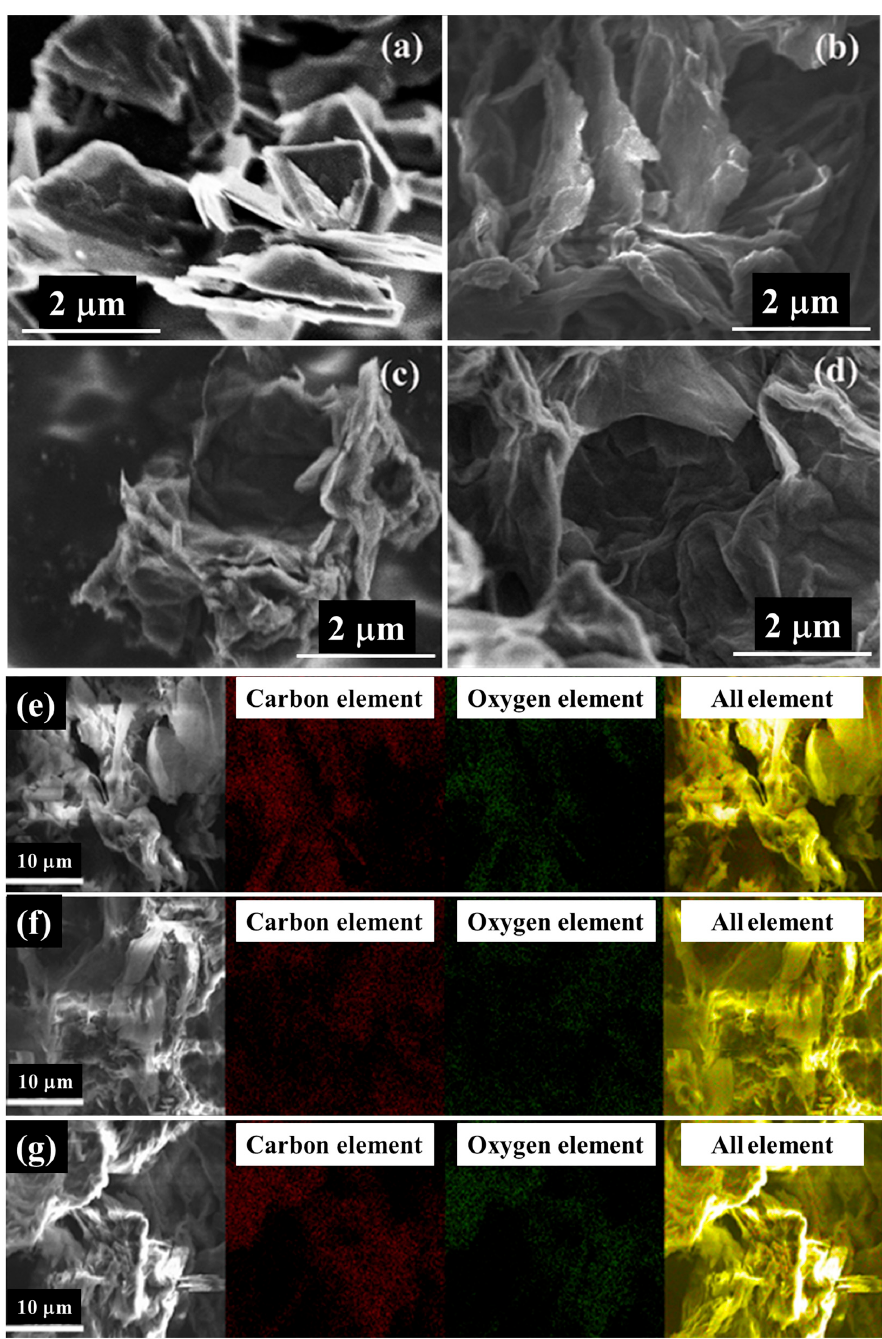
Figure 2. SEM images of graphite powder and three types of GOs: ( a ) graphite powder, ( b ) GO-M1, ( c ) GO-M2 and ( d ) GO-M3. SEM images and their corresponding elemental mapping images of three types of GOs: ( e ) GO-M1, ( f ) GO-M2 and ( g ) GO-M3. The mapping images (Figure 2e–g) and EDS element semi-quantitative analysis re- sults (Table 1) revealed that all three types of GOs are dominated by carbon and oxygen elements and the content of impurity elements is extremely low, which indicates that the samples were thoroughly cleaned during the preparation process and the samples were